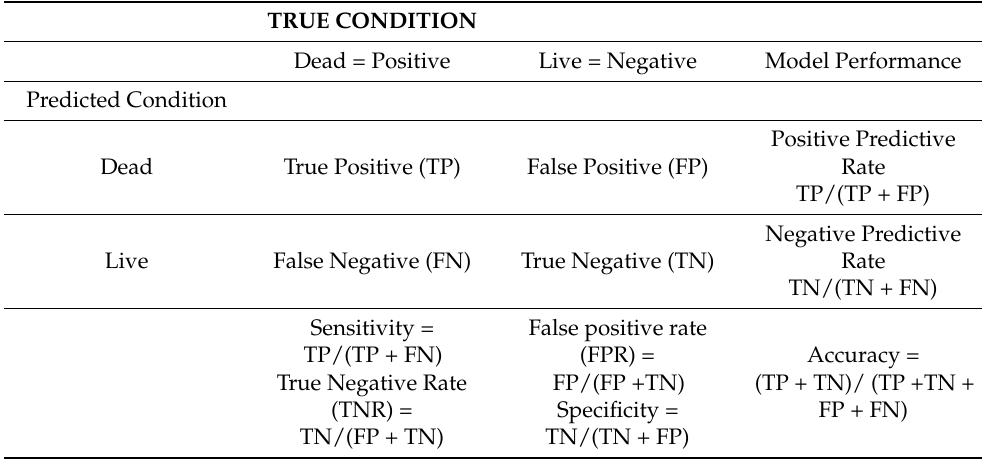
Table 3. Classification table and model performance statistics used to evaluate delayed mortality model. Adapted from